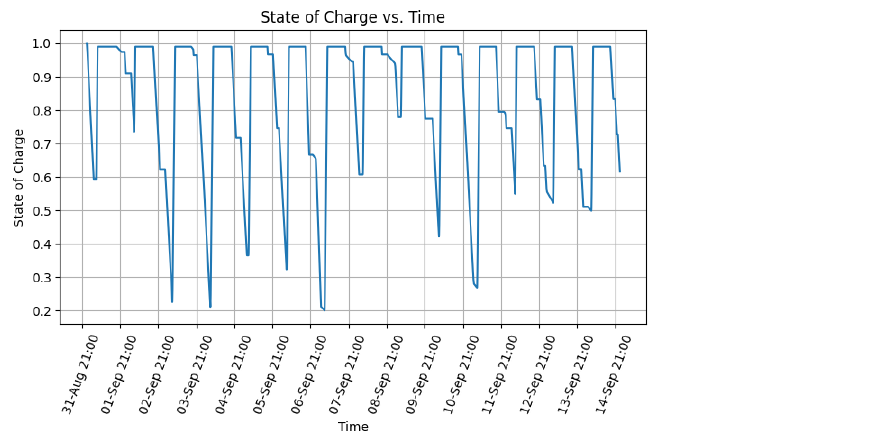
Figure 7. Power profile for a microgrid with 8520 kW photovoltaic power rating and 851 kW Daytime photovoltaic power is orders of magnitude greater than load and other DER capacity.